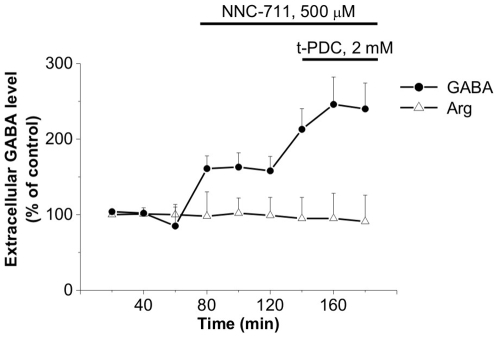
Elevation of [GABA]o in the rat hippocampus in vivo following NNC-711 and t-PDC administration (n = 10, P = 0.019 (t-PDC vs. NNC-711), NNC-711: 160±18, t-PDC: 233±33, % of control). [Arginine]o was used as a control for possible non-specific release (n = 10, P = 0.6, NNC-711: 100±25, t-PDC: 94±32, % of control).